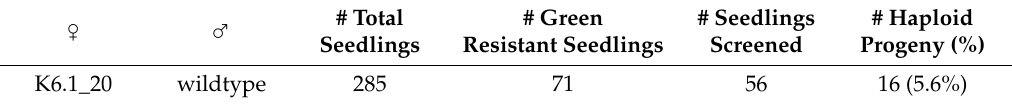
Table 3. Haploid production from a 4 x RKD2gBB_6.1 T1 plant pollinated with wildtype